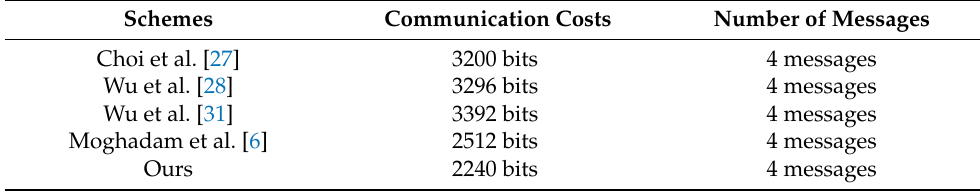
Table 4. Communication costs comparison.